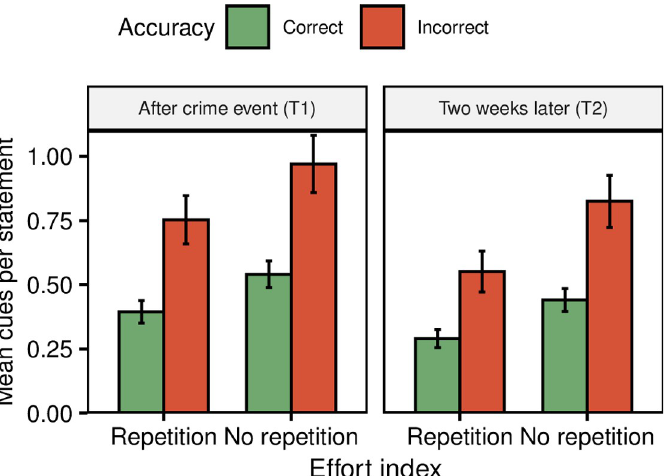
Fig 4. Effects of accuracy, time and repetition on the retrieval-effort index. Note. Error bars represent 95% confidence intervals.